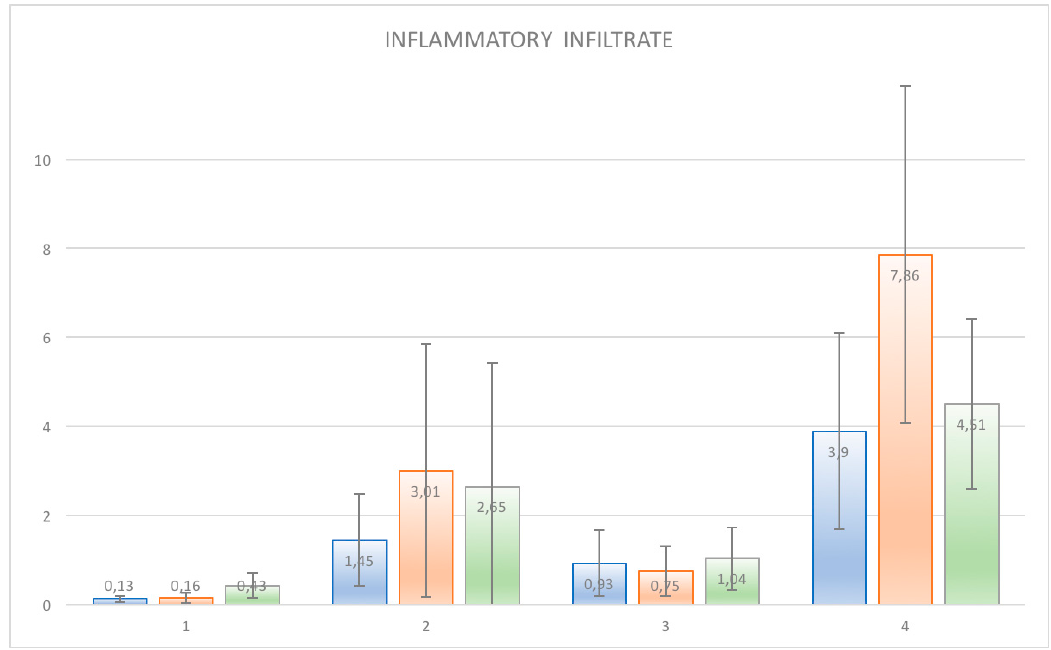
Figure 8. Graphical representation of different markers expression. Markers were evaluated individually. Statistical significant differences between groups were find. Inflammatory infiltrate evaluated by CD3 (in blue), CD20 (orange), and CD68 (green).